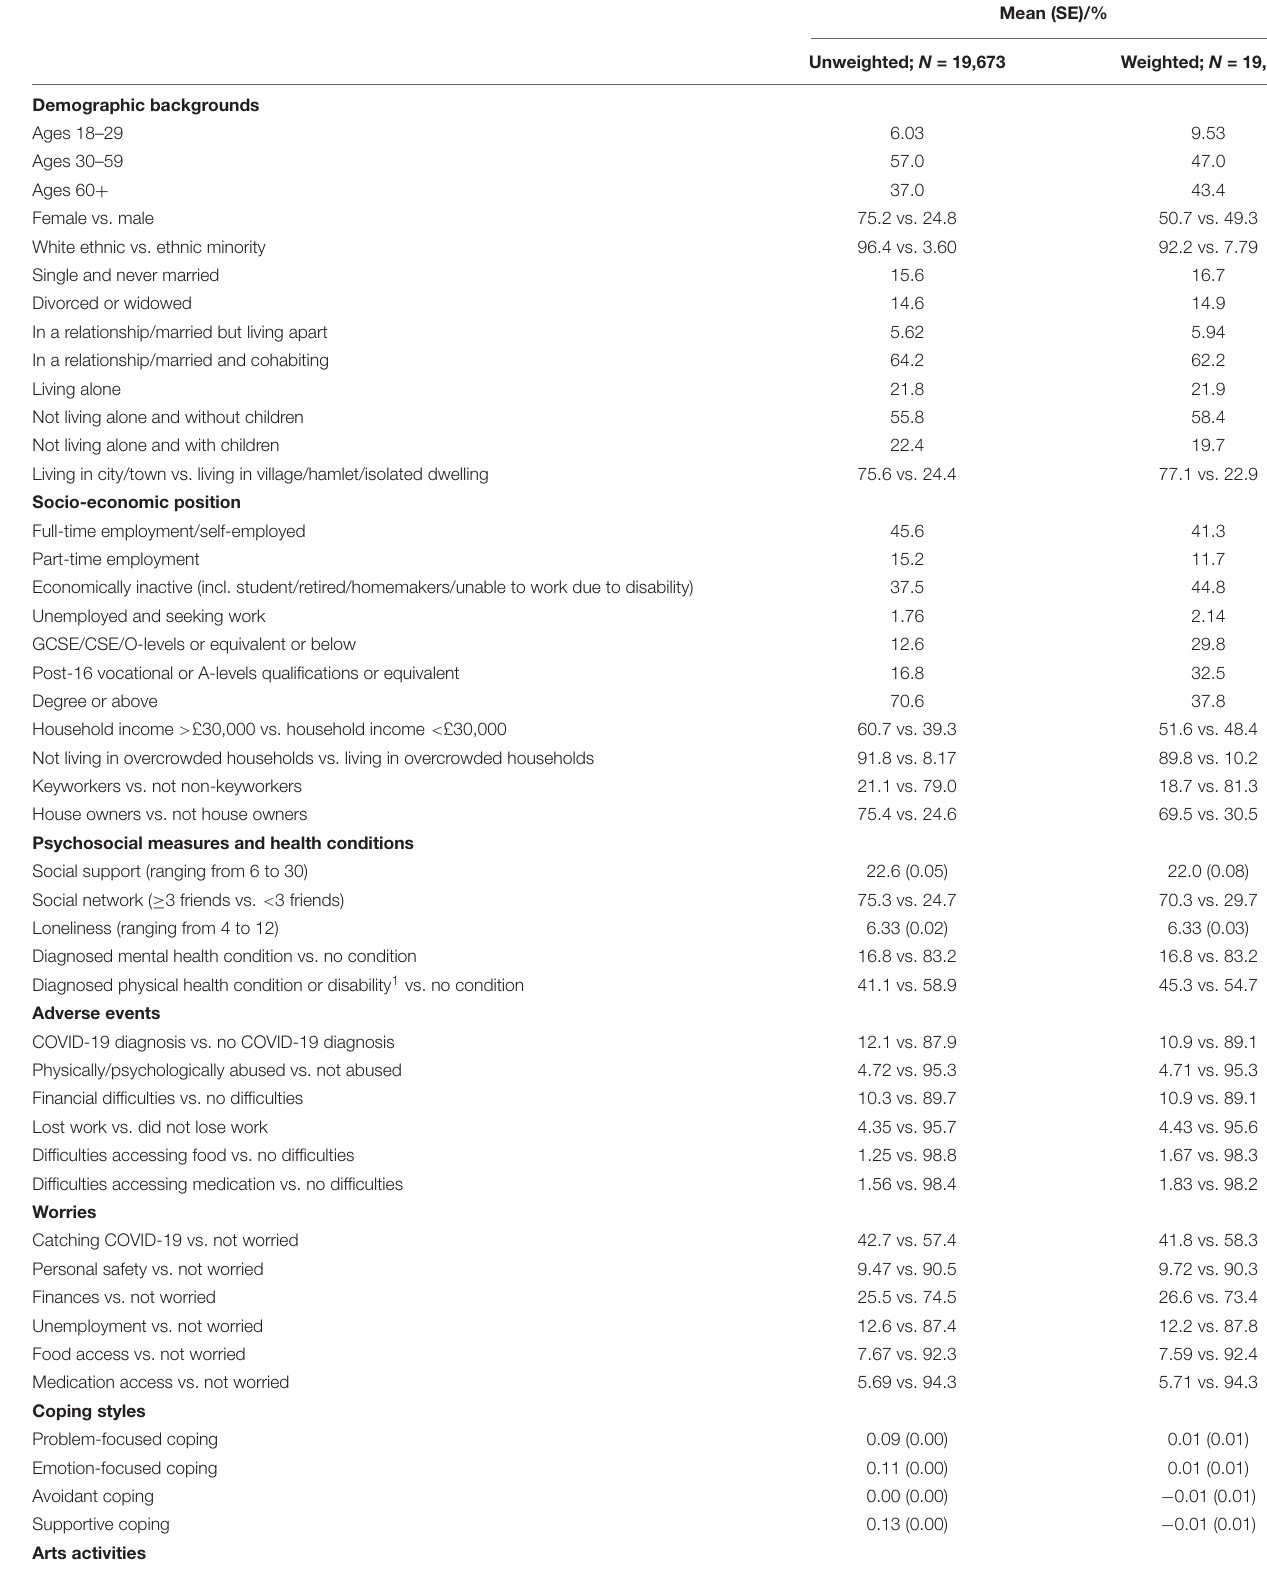
TABLE 2 | Descriptive statistics of the analytical sample (unweighted and